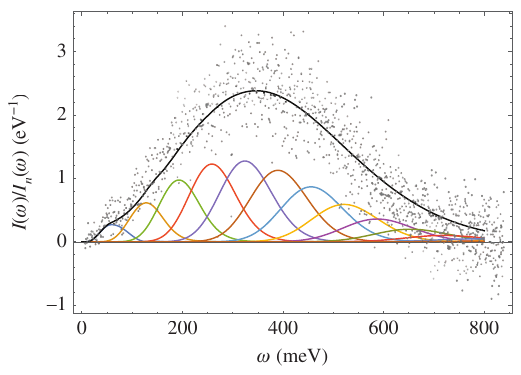
Figure 5: The PSB spectrum from experiment (gray points), a polynomial fit of the spectrum to show its centerline (dashed blue), the calculated PSB (dashed orange), and its constituent n -phonon bands. The sum of n -phonon bands equals the calculated